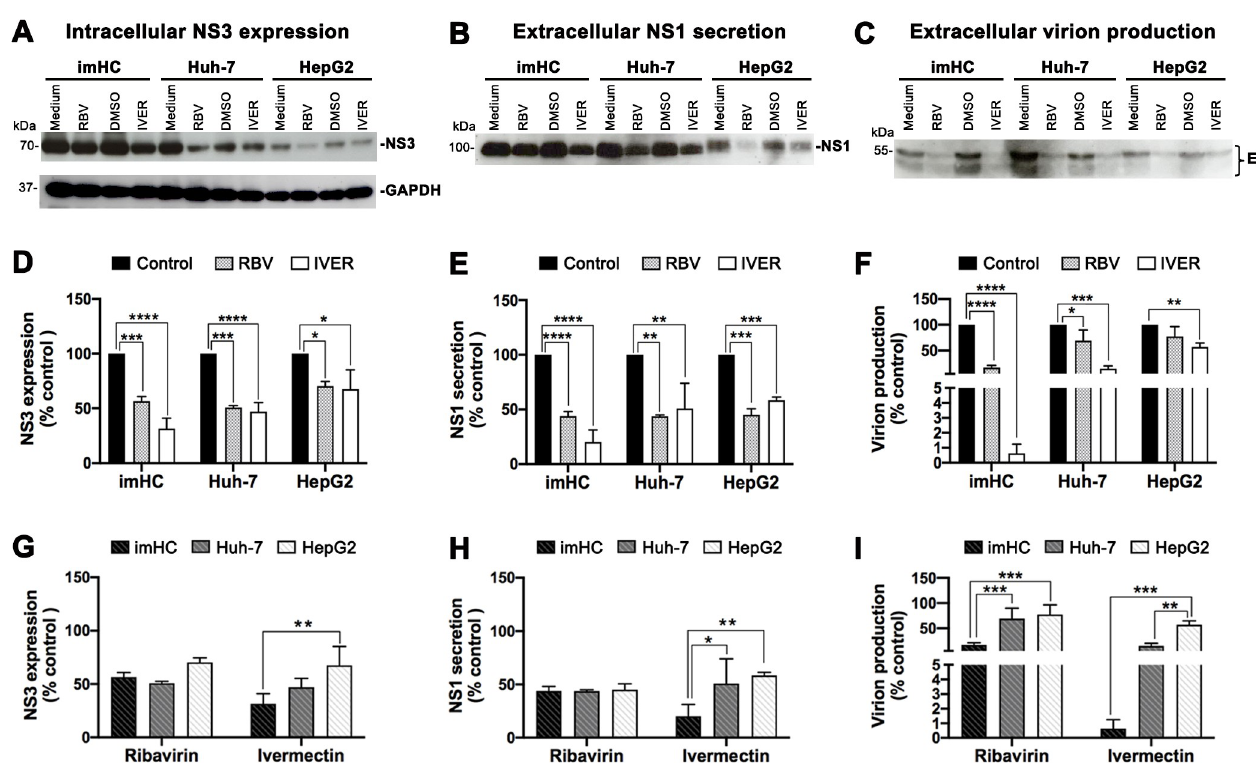
Fig 8. Differential inhibitory effects of anti-viral drugs on DENV replication in three hepatic cell lines. The three cell lines (HepG2, Huh-7, imHC) were infected with DENV-2 at MOI of 0.1 and cultured in media with or without drugs [5 μ M of ivermectin (IVER) or 10 μ M of medium-soluble ribavirin (RBV)]. Plain medium or medium containing 0.5% DMSO (used for ivermectin solubilization) was also used as control vehicles for ribavirin and ivermectin treatment, respectively. At 48 h post infection, the cells and culture supernatants were collected for assessment of drug effects on viral production and DENV antigen expression as follows: ( A-C ) Levels of indicated DENV antigens were determined by Western blotting analysis and GAPDH was used as an internal control protein, ( D and G ) Percentages of cells with cytoplasmic NS3 expression determined by flow cytometry, ( E and H ) NS1 secretion levels in culture supernatants quantified by ELISA, ( F and I ) Virion levels in culture supernatants determined by FFU assay. The data from drug treatment conditions of different cell types were calculated as percentages of their corresponding control vehicles. All data are presented as mean ± S.D. of values from three independent experiments. Asterisks indicate significance differences between conditions or cell types ( � P < 0.05; �� P < 0.01; ��� P < 0.001; ���� P <